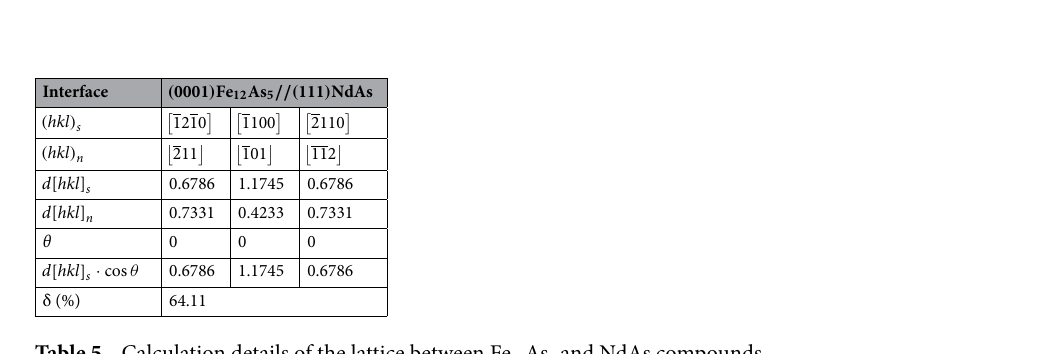
Table 5. Calculation details of the lattice between Fe 12 As 5 and NdAs